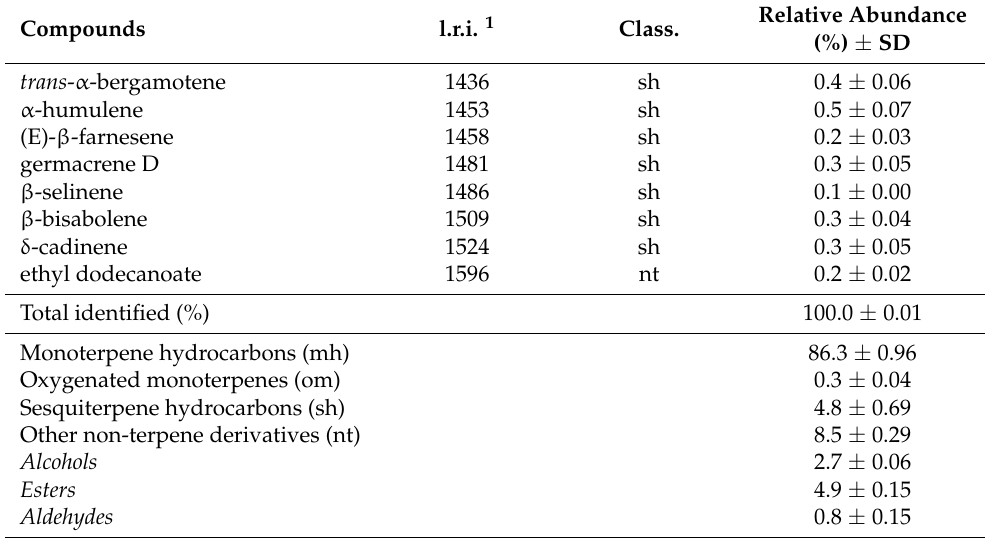
Figure 4. Score ( left ) and loading ( right ) plots of the principal component analysis (PCA) performed on the complete composition of the Cascade hop EO and the headspaces of the plant materials and the beverages. The distribution of the samples in the score plot was comparable to the clustering of the PCA analysis. SPME Hop was plotted by itself in the leftmost area of the bottom left quadrant (PC1 and PC2 < 0): greater distance to all other analyzed samples evidenced low compositional similarities. Both beer samples were positioned close to each other in the lower right quadrant (PC1 > 0 and PC2 < 0), probably due to their relevant content in non- terpene esters, whose vectors were directed towards the rightmost area of the bottom right quadrant. Finally, the samples of the green cluster of the HCA analysis were plotted in the upper quadrants (PC2 > 0), near the separation line between the left and the right ones. The positioning of the sample hop EO in the upper left quadrant was probably due to the α - humulene and β -caryophyllene vectors, whilst the hibiscus liqueur was plotted in the middle area of the upper quadrant because of the high relative content in limonene, whose vector pointed towards the same area of the score plot. 3.4. Sensorial Analysis The scores and the radar graph of the QDA sensorial analysis for both the control and the treated samples are reported in Table 6 and in Figure 5, respectively. In the descriptive analysis, the control beer showed no turbidity and medium foam persistency. In the olfactory and gustative phase intensity, malty and hoppy notes were